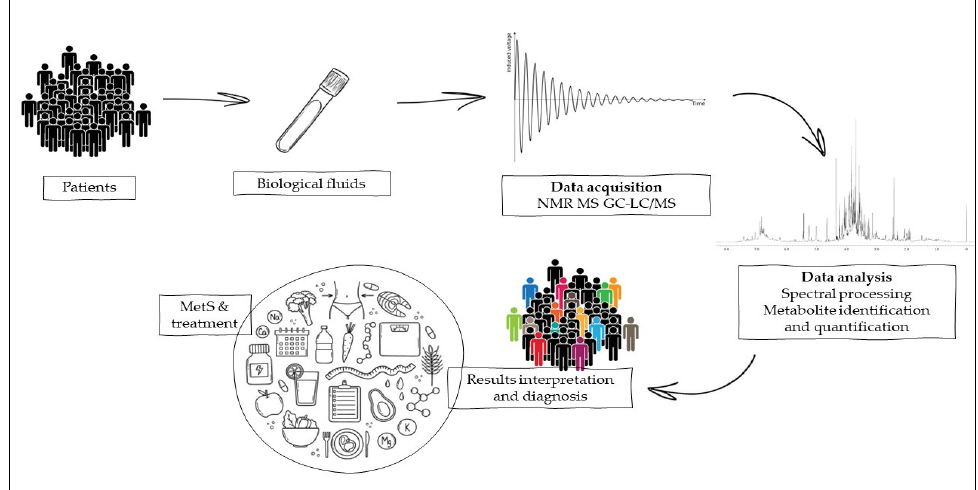
Figure 1. Metabolomics experimental work from biological samples of patients for the interpretation of the results obtained by nuclear magnetic resonance (NMR) or mass spectroscopy (MS), coupled to targeted techniques such as gas and liquid chromatography (GC and LC).